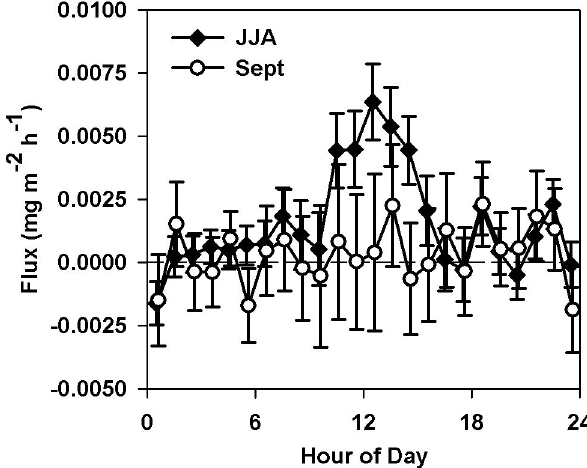
Fig. 7. Diel average flux at m / z =153 during June, July, and Au- gust, compared to that for September. The error bars are the 2- σ uncertainty estimate derived from the covariance at lags far away from the true lag, as described in the